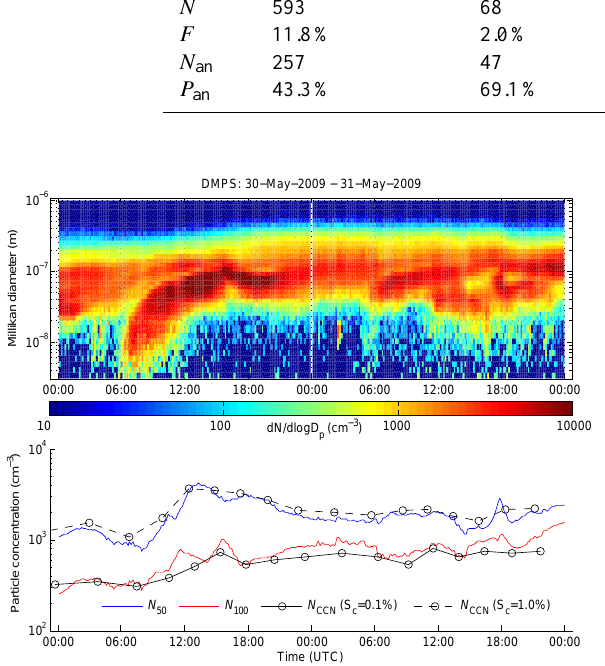
below 1.0 %, and N 100 represents the CCN concentration ac- curately for S c slightly above 0.1 %. Both these events oc- curred in air mass with relatively high and persistent particle number concentrations in the accumulation mode. As a re- sult, CCN measured prior, during and after the event included both nucleated and primary aerosol